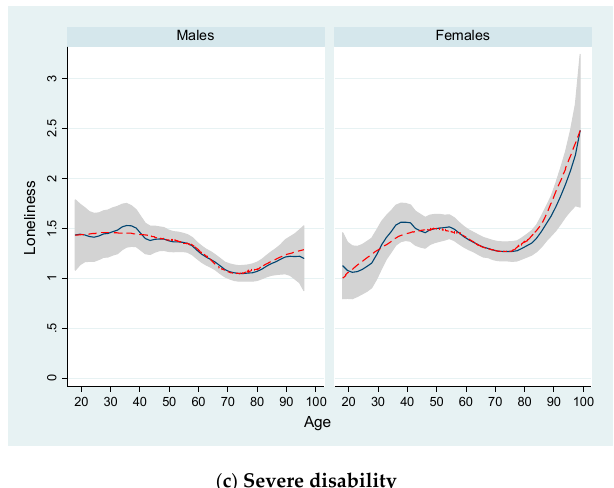
Figure 2. Mean loneliness distribution by age and disability status for German males and females. Note: Individuals aged 16 or over. LOWESS (red dashed lines) and LPOLY (black lines with confidence intervals ( p < 0.05) in grey) smoothing functions shown. For the number of observations used to obtain these results, see the notes in Figure 1. Source: SOEP data for the years 2013 and 2017.